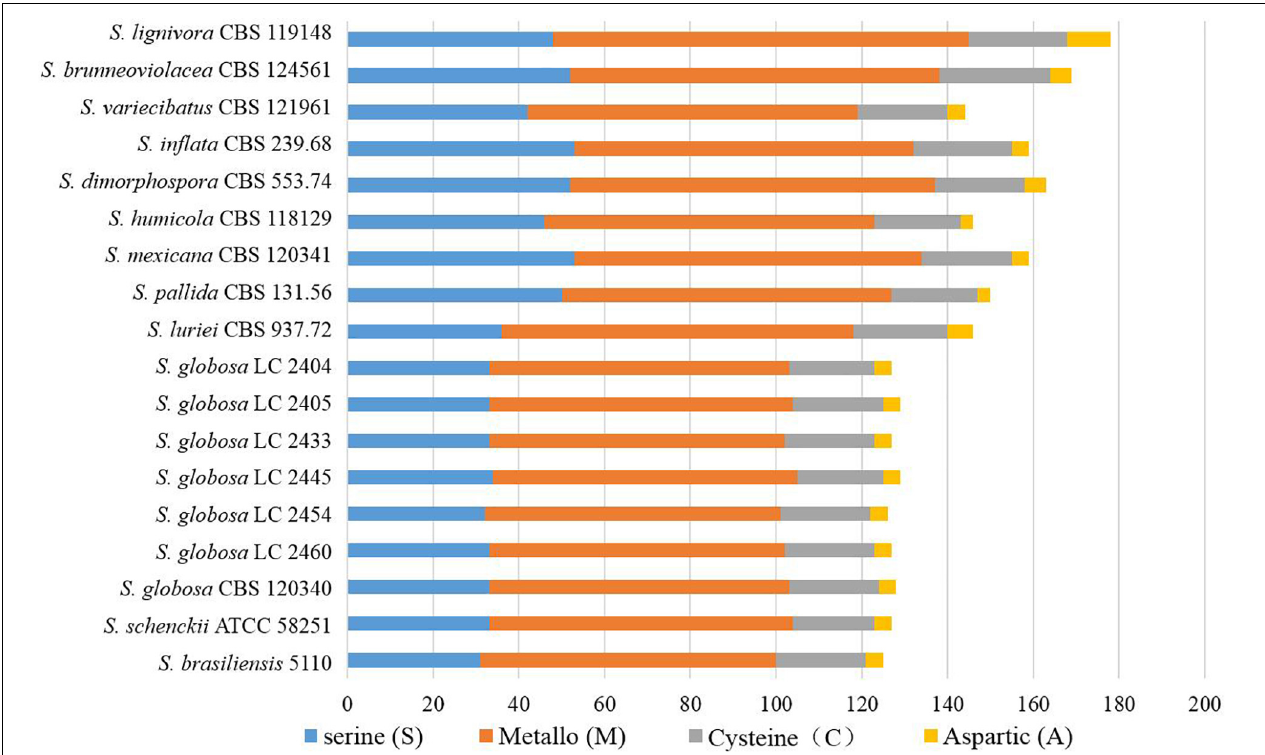
FIGURE 6 | Gene contraction of peptidases in the genus Sporothrix. Protease-coding genes of Sporothrix identified through Pfam database were classified into 4 categories. The largest category of predicted proteases in the Sporothrix genome was Metallo (M), followed by Serine (S), Cysteine (C), and Aspartic (A) proteases.